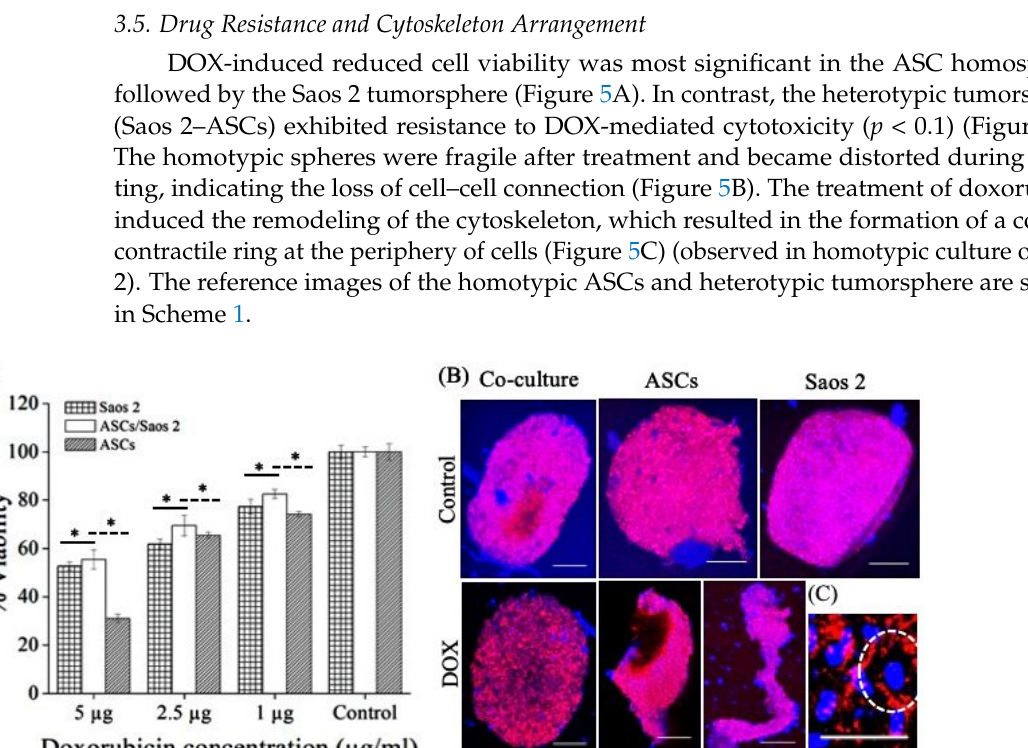
Figure 4. Homo- and heterotypic tumorspheres treated under osteogenic conditions. ( A ) Element analysis of mineralization; ( B ) SEM images of mineralized deposition of calcium phosphate. Scale bar = 50 μ m.